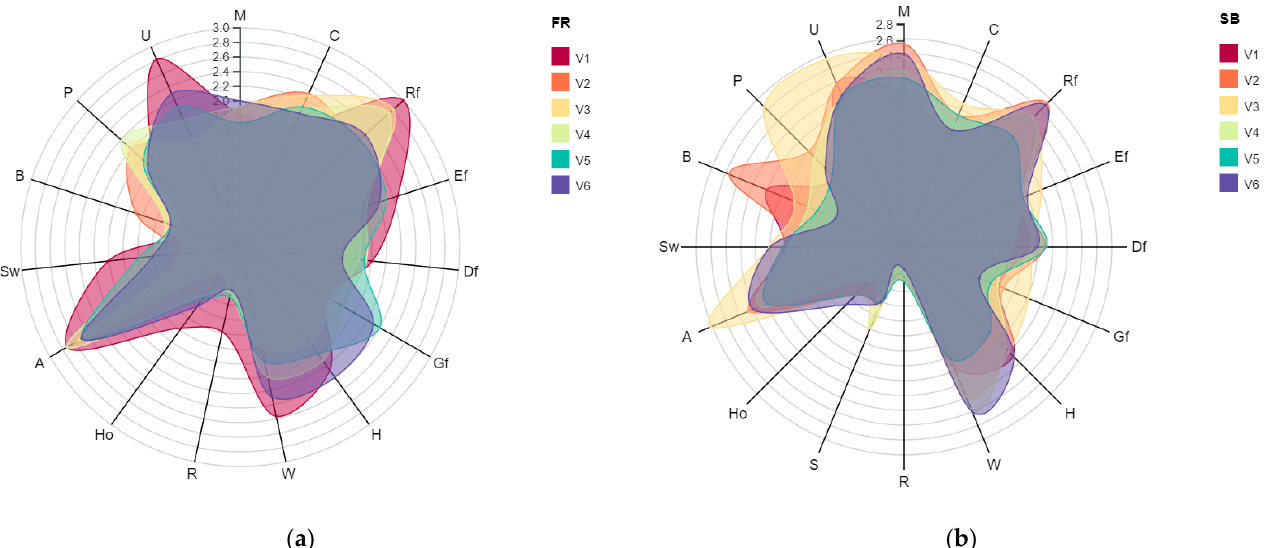
Figure 4. The influence of enzymes on wine’s sensory perception ( a —Feteasc ă regal ă ; b —Sauvignon blanc). FR—Feteasc ă regal ă ; SB—Sauvignon blanc; V1—Endozym Thiol ® , AEB; V2—Endozym β -Split ® , AEB; V3—Zymovarietal aroma G ® , SODINAL; V4—Endozym Ice ® ,